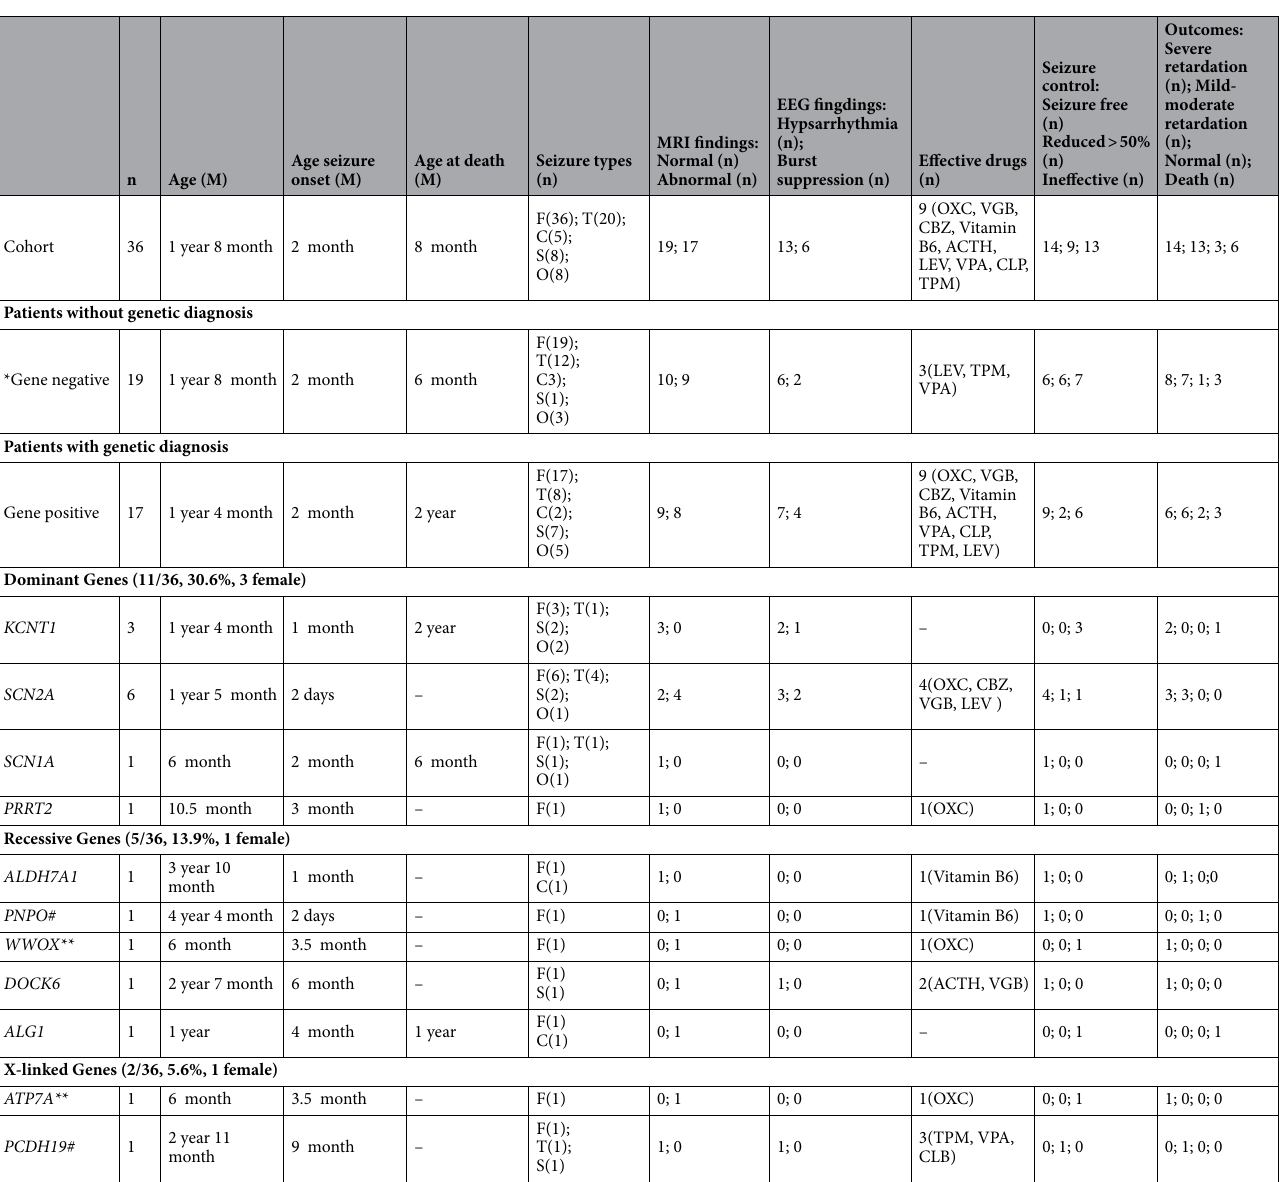
Of the 36 patients with EIMFS, 19 had normal MRI findings, of which 9 (9/19, 47.4%) were seizure free, 9 (9/19, 47.4%) had ineffective seizure control, 7 (7/19, 36.8%) had severe retardation and 2 (2/19, 10.5%) died. Also, 17 had abnormal MRI, of which 5 (5/17, 29.4%) were seizure free, 8 (8/17, 47.1%) had ineffective seizure control, 7 (7/17, 41.2%) had severe retardation and 4 (4/17, 23.5%) died. The details are shown in Table 4. Of the 36 patients with EIMFS, 13 had hypsarrhythmia, of which 5 (5/13, 38.5%) were seizure free, 6 (6/13, 46.1%) had ineffective seizure control, 6 (6/13, 46.1%) had severe retardation, 2 (2/13, 15.4%) died and 0 (0/13, 0%) were normal; also, 7 had burst suppression, of which 1 (1/7, 14.3%) were seizure free, 1 (1/7, 14.3%) had inef- fective seizure control, 3 (3/7, 42.9%) had severe retardation, 3 (3/7, 42.9%) died and 0 (0/3, 0%) were normal. 3 patients had hypsarrhythmia and burst suppression, of which 1 (1/3, 33.3%) were seizure free, 1 (1/3, 33.3%) had